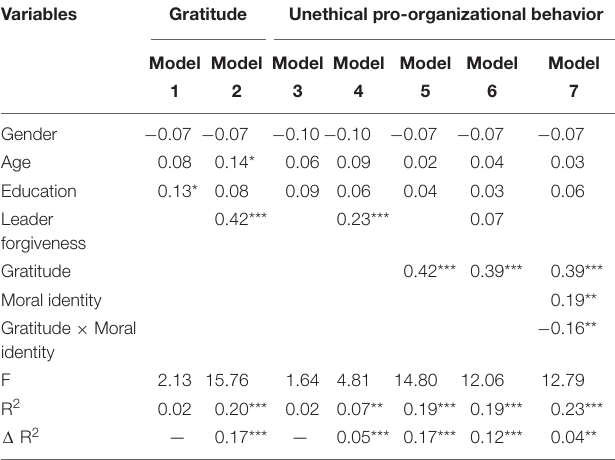
TABLE 4 | Results of regression